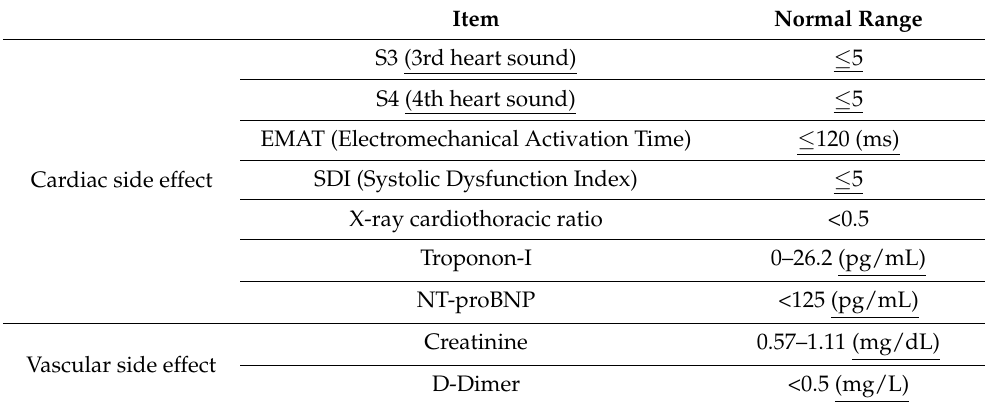
Table 2. Definitions of cardiac and vascular side effects accompanying COVID-19